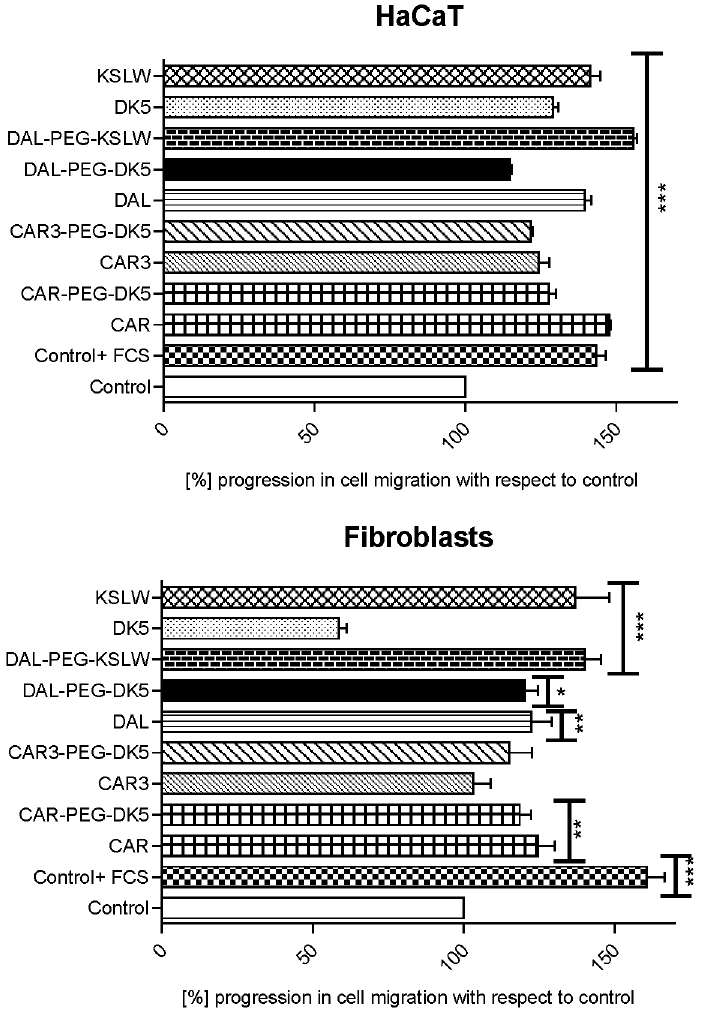
Fig 2. Effect of the peptides on HaCaT keratinocytes and fibroblasts cell migration in the in vitro scratch test. HaCaT cells and fibroblasts were grown in 6-well plates until the 100% confluence was reached, then cells were starved for the next 12 hours in DMEM without 10% FCS and scratched once vertically with a 200 μ L pipette tip. After being washed two times with sterile PBS, a fresh portion of DMEM medium was added and cells were treated with the tested peptides applied at their optimal doses (25 μ g/mL). Migration was analyzed after 24 hours by means of Zeiss Observer D1 microscope, wounding areas were analyzed with AxioVision software and expressed as the percentage of the wound width in comparison to the control sample (cells incubated in DMEM without FCS). Control+ FCS corresponds to the sample with cells incubated in the medium containing 10% FCS and was treated as the additional positive control. Data represent the mean ± SD of three independent experiments. * P < 0.05, ** P < 0.01, *** P < 0.001 vs.